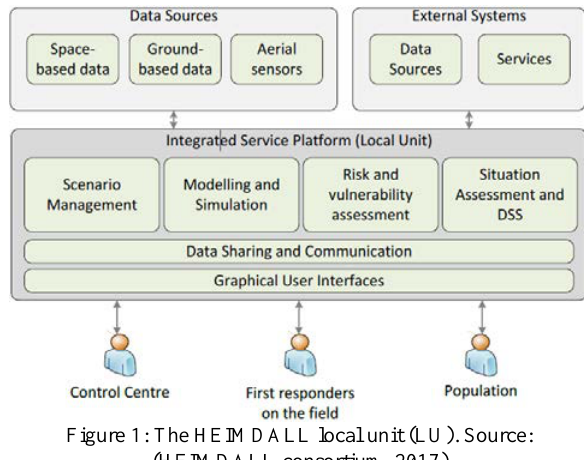
Figure 1: The HEIMDALL local unit (LU). Source: (HEIMDALL consortium,